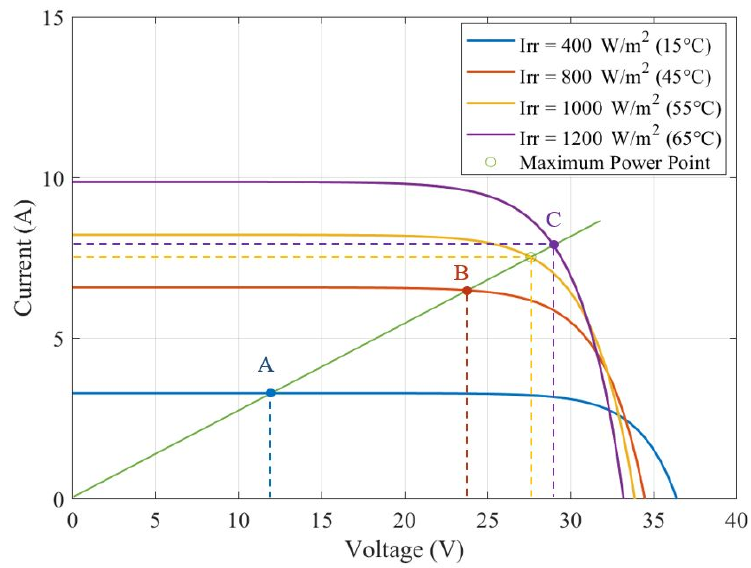
Figure 6. Variations of the working point and variations of the input current and voltage.